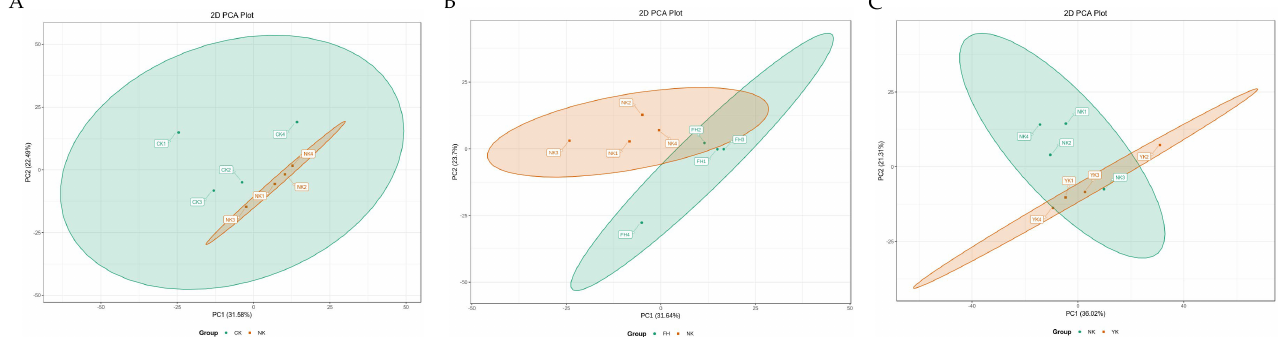
Figure 4. PCA plots of samples from CK group, NK group and YK group. ( A ) CK group vs. NK group; ( B ) NK group vs. FH group; ( C ) NK group vs. YK group.